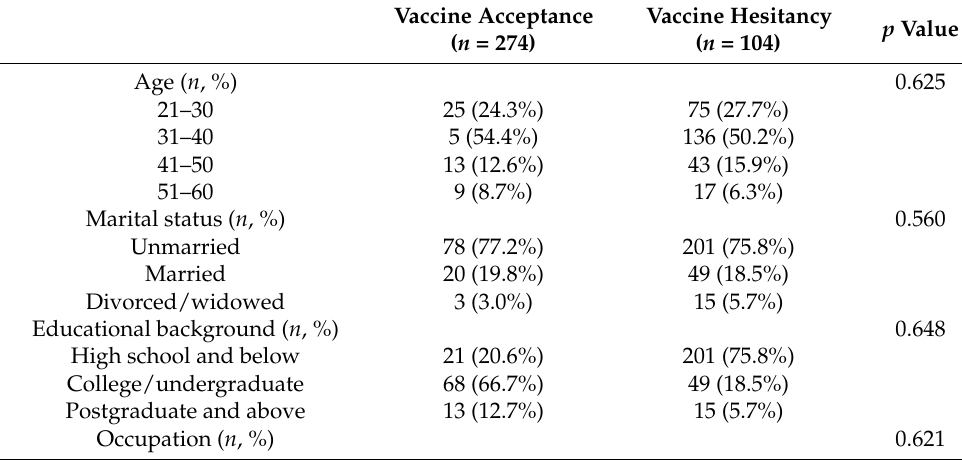
Table 4. Probable effect factors associated with vaccine hesitancy of